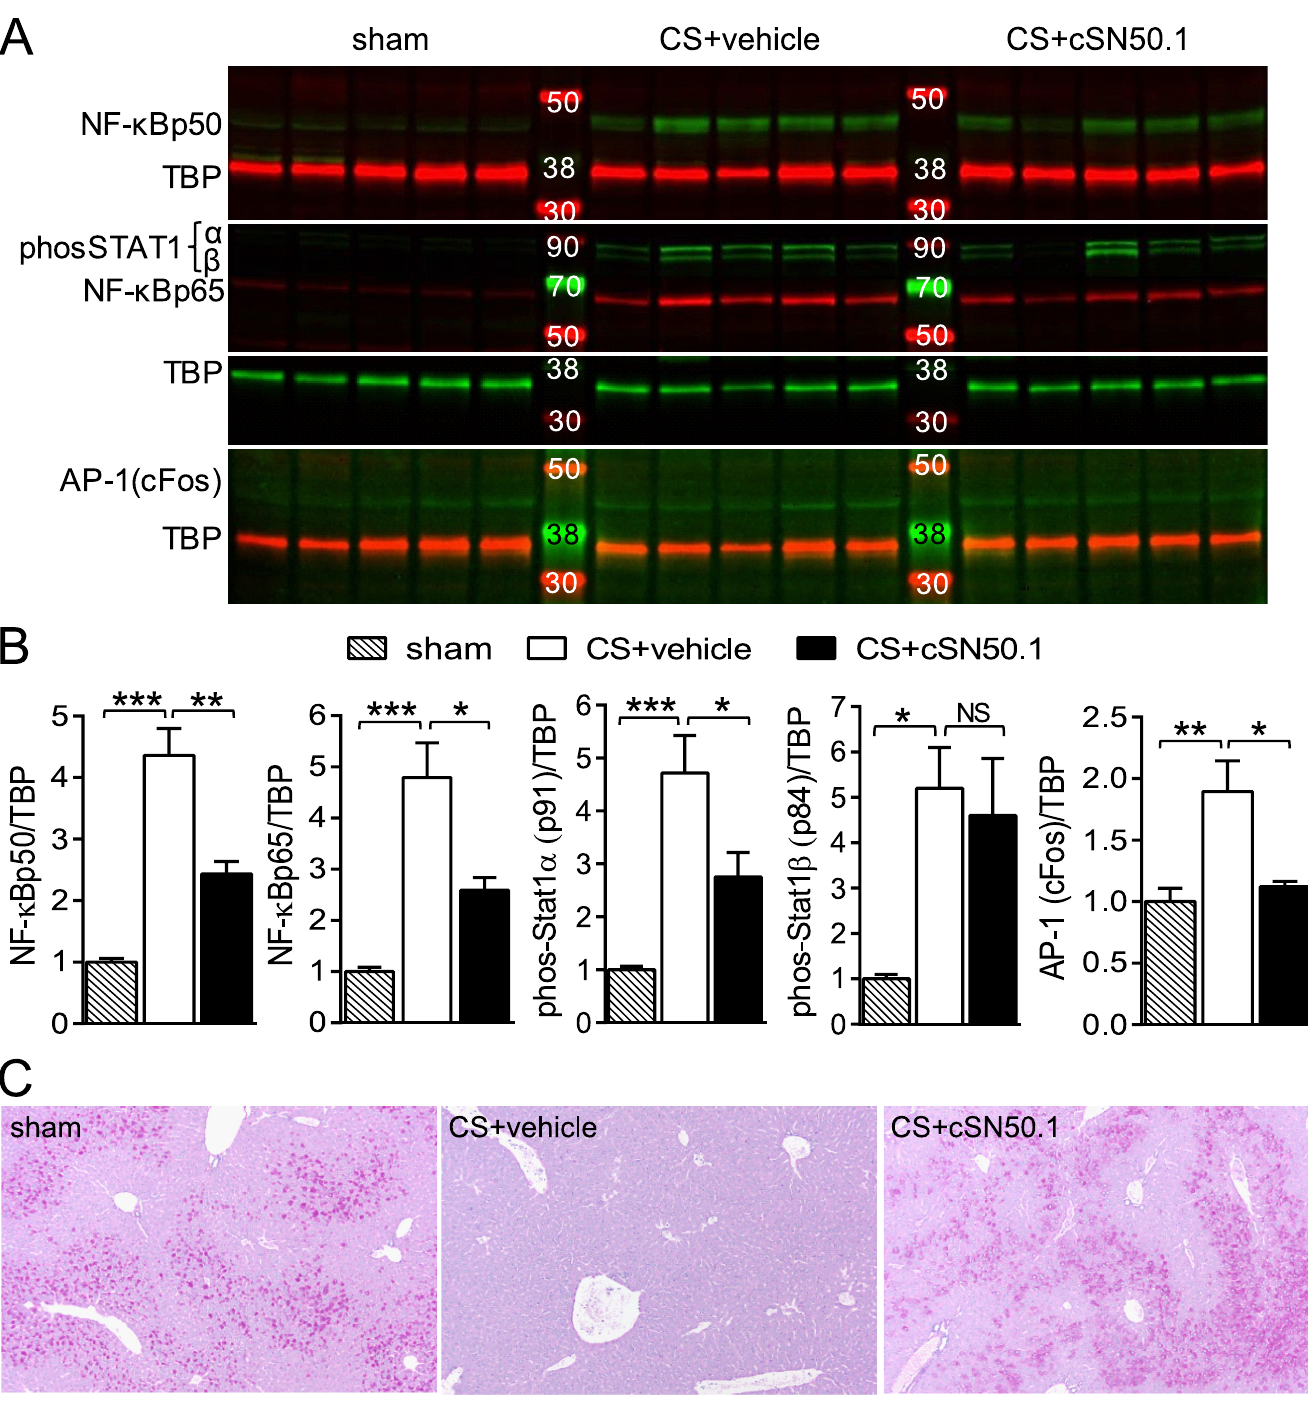
Fig 2. Nuclear transport of SRTFs is reduced and normal liver architecture is protected in infected mice treated with NTM. ( A ) Nuclearcontent of NF- κ Bp50, NF- κ Bp65,pY701 phospho-STAT1 α (MW 91) and -STAT1 β (MW 84), and AP-1 (cFos) in livers collected12 h after infectionfrom sham- infected or CS-infectedmice treated with NTM (cSN50.1) or vehicle. Each lane is the nuclearextract from one mouse; lanes shown in each row are from the same gel. Immunoblotsshown are representative of 2 independent nuclear extract preparations. ( B ) Quantitative analysisof immunoblots shown in A. All samples were normalized to TATA bindingprotein (TBP) on the same immunoblot (Data points are displayedas mean + SEM of fold change, n = 10/ group; * p < 0.05, ** p < 0.005, *** p < 0.0001 by t test, NS = not significant). ( C ) Liver sections collected12 h after infectionfrom sham-infected or CS- infected mice treated with NTM (cSN50.1) or vehiclestained with PAS. Images are representative of 5 mice/group.